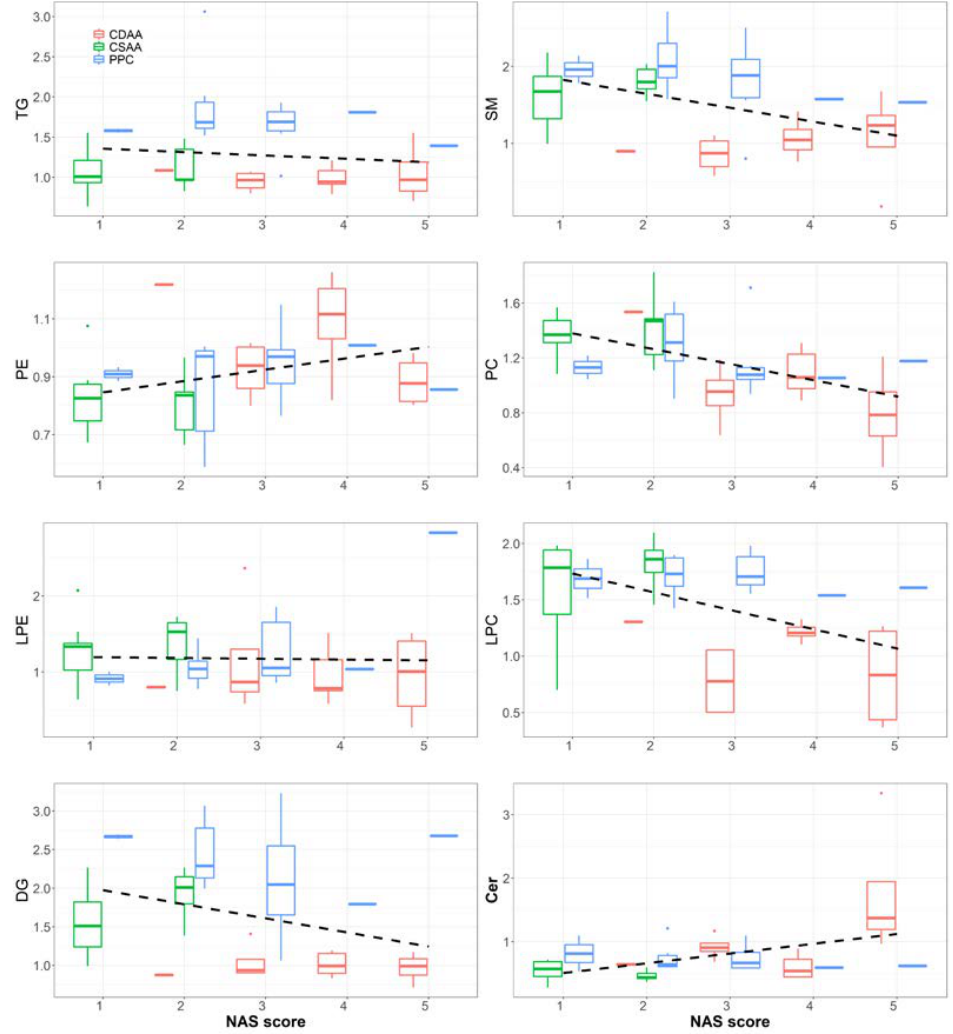
Figure 7. Analysis of the trend between the NAS score and the relative value of the lipids in the serum; a larger NAS value indicates a greater NAFLD severity. Table 2. Fold changes of the serum lipid species in the C57BL/6 mice after being fed a CDAA diet.